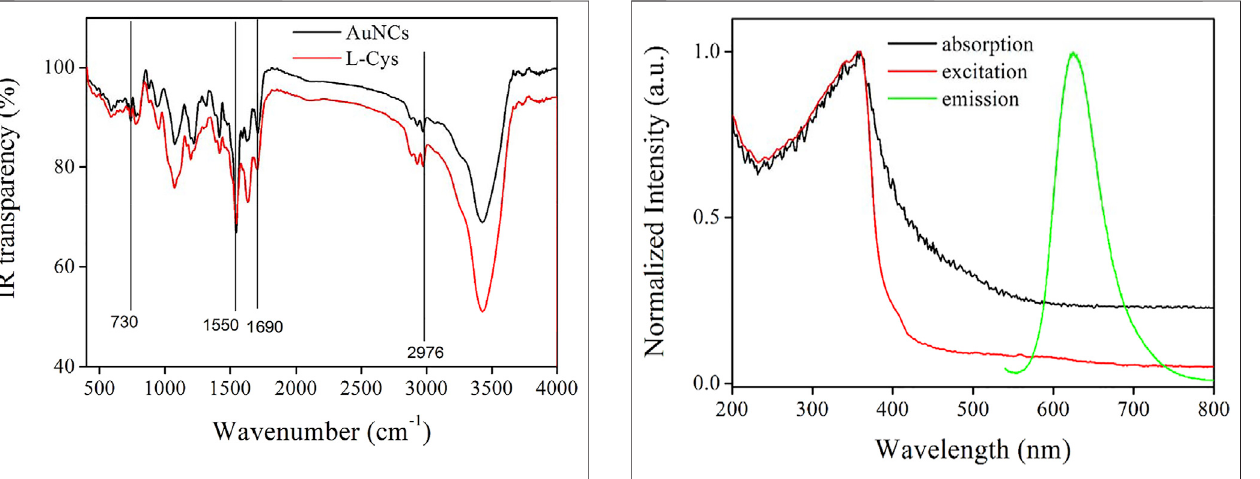
FIGURE 5 | IR spectra of L-Cys and as-synthesized AuNCs.